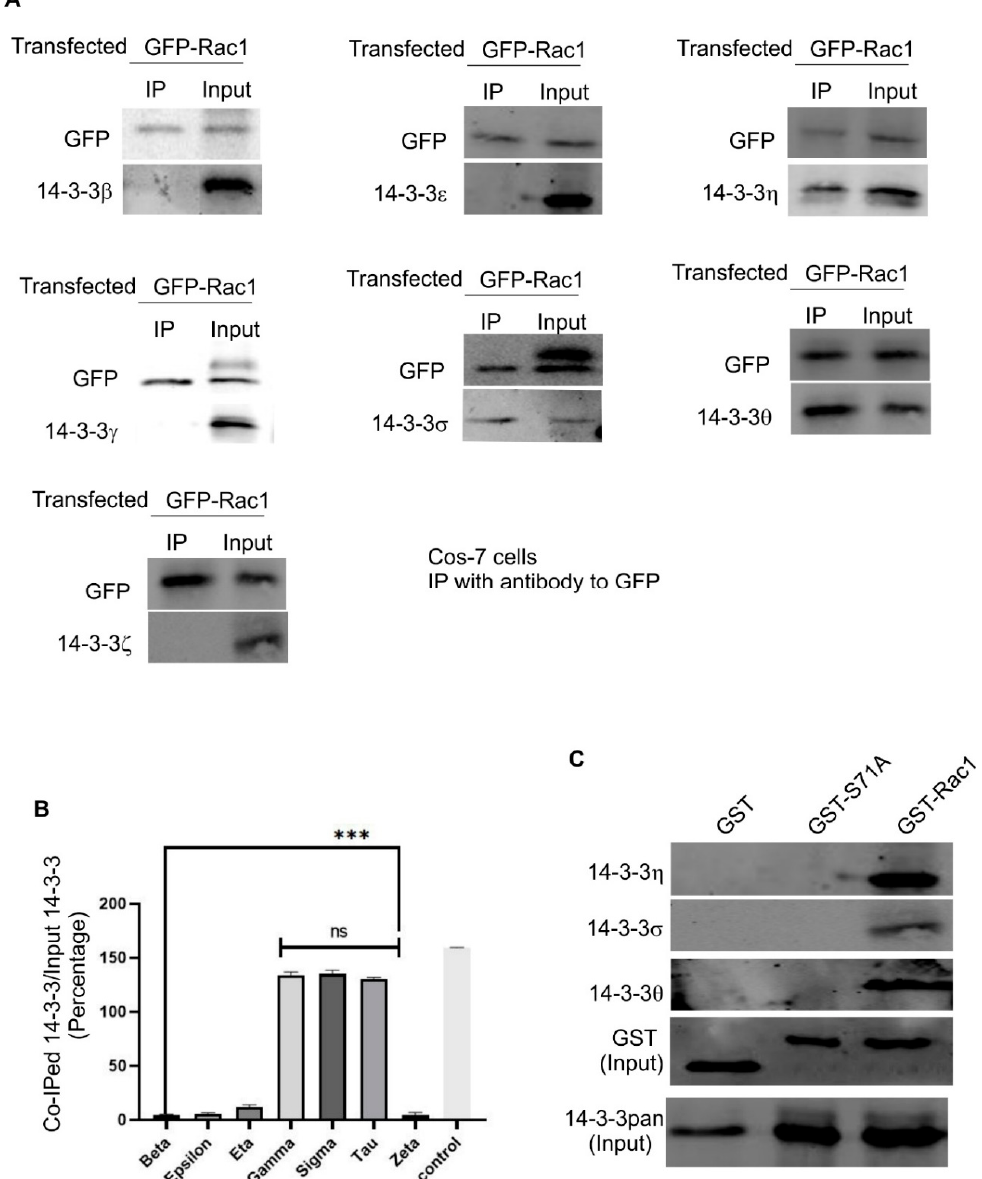
Figure 4. The interaction between Rac1 and seven 14-3-3 isoforms in Cos-7 cells. ( A ) Co-IP experiments to determine the interaction between Rac1 and seven 14-3-3 isoforms in Cos-7 cells. Cos-7 cells were transfected with GFP-Rac1. The expressed GFP-Rac1 was IPed with the anti-GFP antibody. The co-IP of various 14-3-3 isoforms was determined by immunoblotting. ( B ) Quantification of the data in ( A ). The levels of co-IPed 14-3-3s were quantitated by densitometry. Each value is the average of at least three experiments and the error bar is standard error. *** p < 0.001, ns: p > 0.1. ( C ) GST pull-down experiments to determine the interaction between three 14-3-3 isoforms including 14-3-3 η , - σ , and - θ and GST-Rac1 and GST-S71A. The Cos-7 lysates were incubated with glutathione agarose beads charged with GST, GST-Rac1 or mutant GST-S71A. The agarose beads were then separated and subjected to immunoblotting analysis with antibodies against 14-3-3 η , - σ , and - θ , GST, and